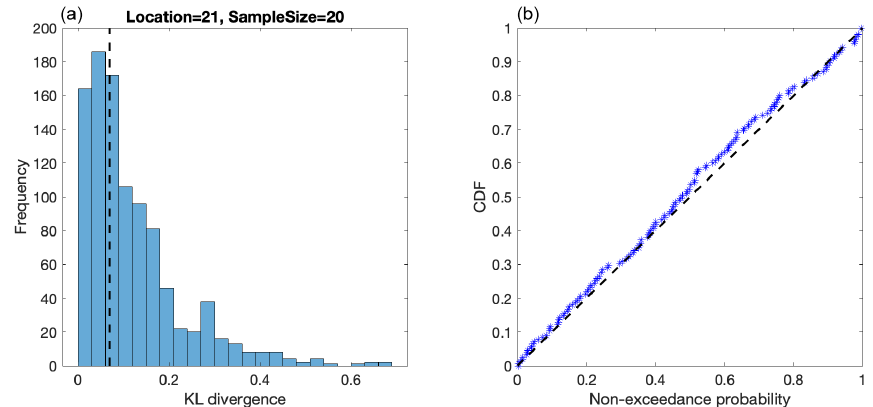
Figure 11. (a) Histogram of KL from random pairs of empirical distribution functions for exposure (corresponding to the “null” distribu- tion of KL), together with KL ∗ for Location 21 with a sample size of 20. (B) QQ plot of the non-exceedance probability of KL ∗ (in the corresponding null distribution for KL) over all locations and sample sizes.